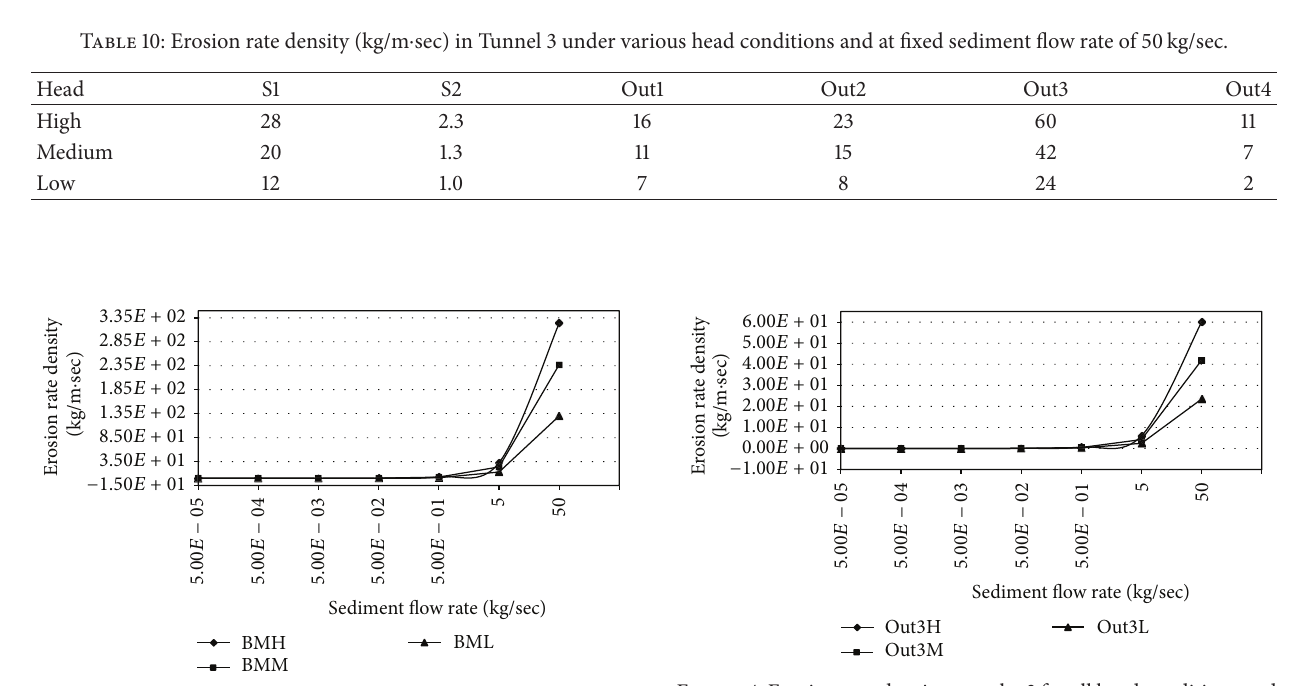
Figure3:Erosionratedensityatmainbranchforallheadconditions and different sediment flow rate in Tunnel 2 (BM: main branch; H: high head; M: medium head; L: low head).